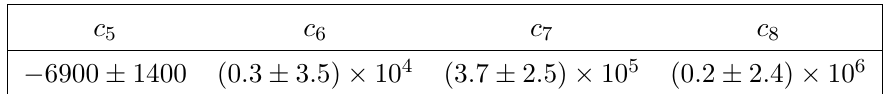
Table 4. Final values for the QCD perturbative coefficients c n of Im Π( s ) ( MS scheme, N f = 5